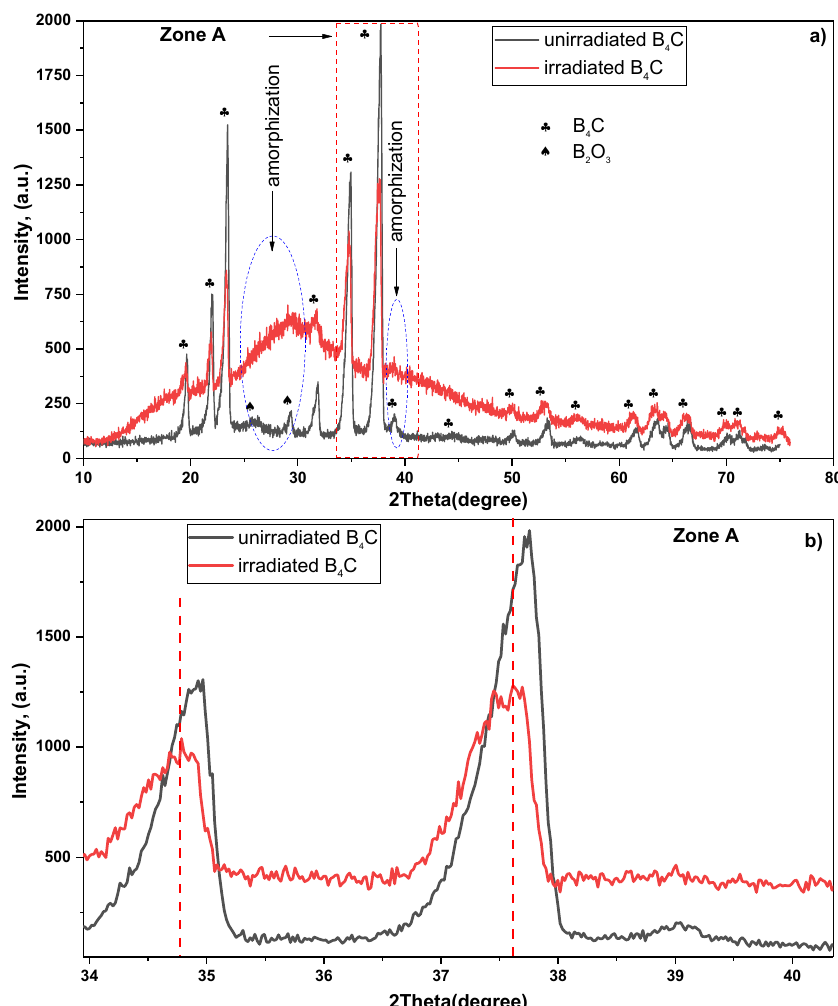
Figure 1. X-ray diffraction. On the top, ( a ) is the X-ray diffraction of unirradiated (black line) and irradiated boron carbide (red line), on the bottom, ( b ) is the enlarged part labeled as Zone A. The XRD is able to probe through the entire depth of our B 4 C sample; thus, the XRD data graph shows signals from different zones in the sample: undamaged, as well as the damaged and amorphized zones.